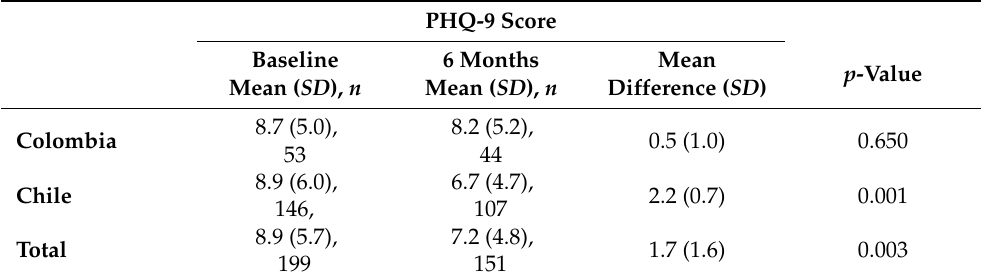
Table 2. Mean PHQ-9 score at baseline and 6-month follow-up and mean differences by country.